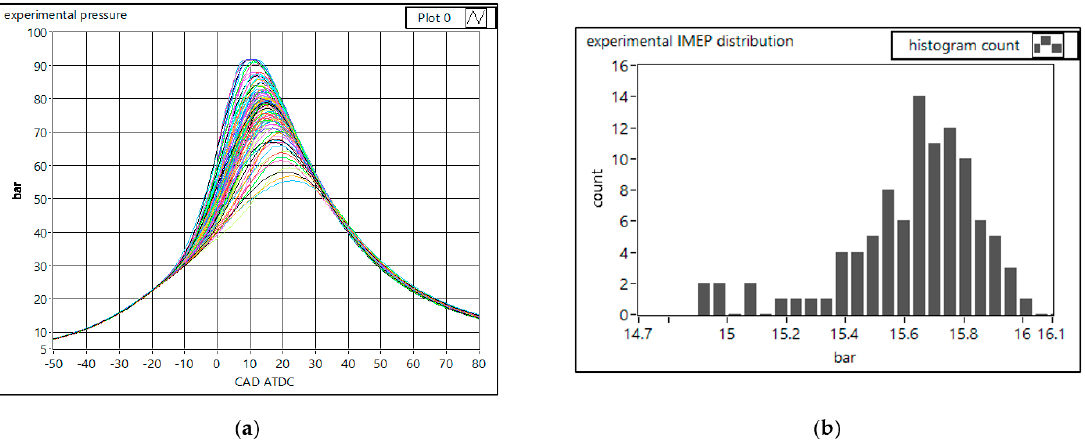
Figure 17. MAP = 1.6 bar, engine speed n = 2500 rpm, fuel 100% NG. ( a ) 100 consecutive pressure cycles; ( b ) histogram of IMEP distribution (mean value = 15.6 bar, SD = 0.239